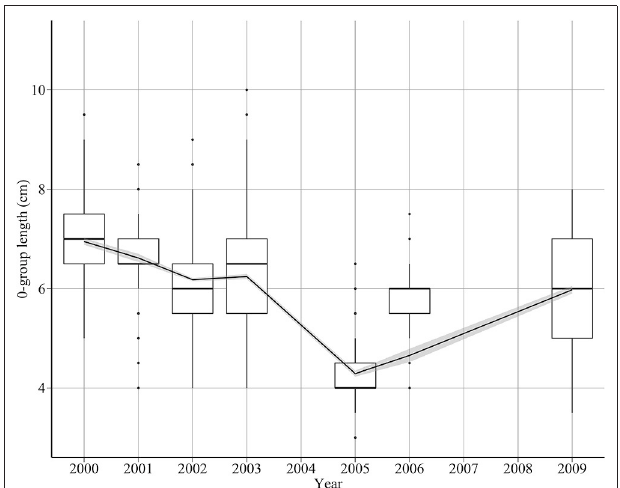
FIGURE 3 | Changes in sandeel 0-group length between 2000 and 2009. The solid line indicates a loess smooth through the data.